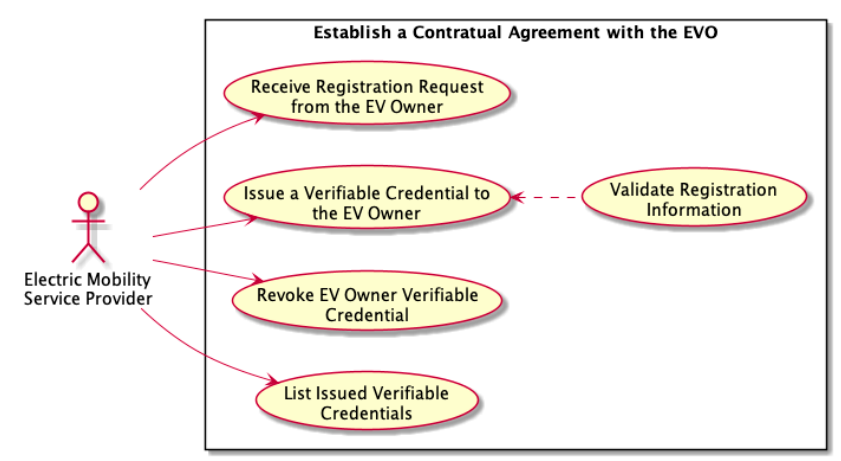
Figure 8. Electric Mobility Service Provider user cases.